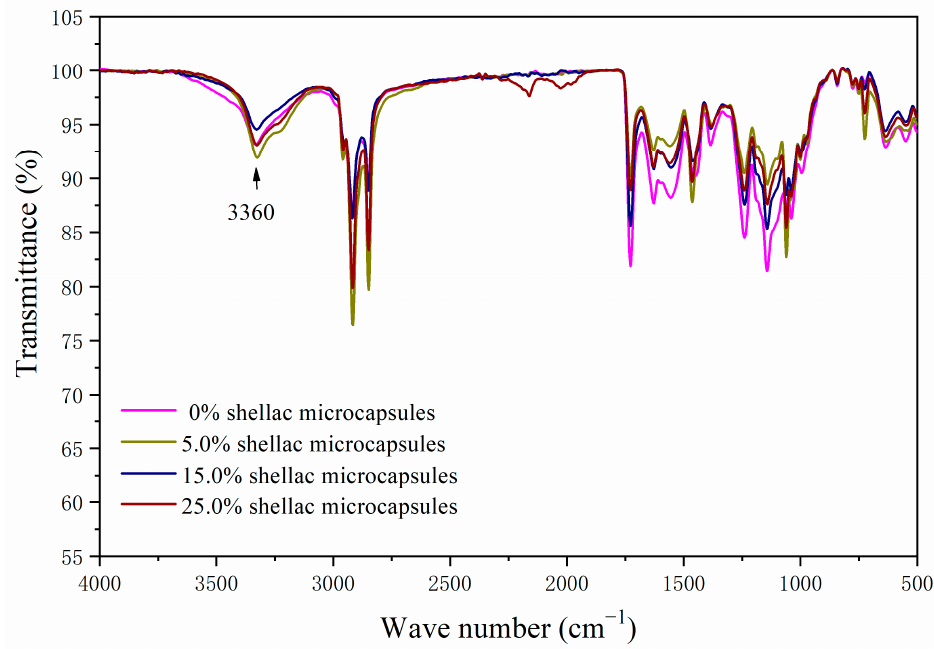
Figure 5. Infrared spectrum of coatings with different contents of shellac